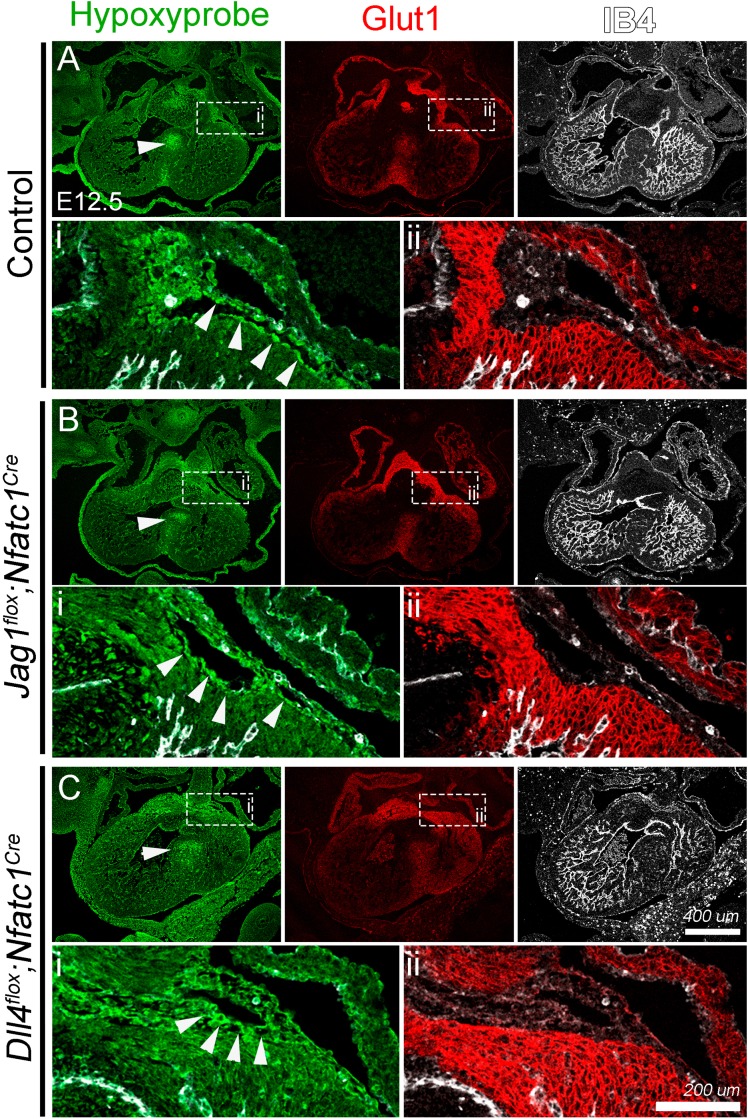
No evidence of hypoxia in Jag1flox;Nfatc1Cre and Dll4flox;Nfatc1Cre hearts at E12.5.(A) WT heart. Hypoxyprobe-1 (hypoxyprobe; green) staining is found in the ventricular septum (arrowhead), the AV groove (i), and in chamber and valve endocardium. A subset of valve mesenchymal cells in the AV cushions is also distinctly positive for hypoxyprobe. (i) Magnification of the sub-epicardial mesenchyme layer region. hypoxyprobe labels endothelial cells lining the vessels emerging from the AV groove (arrowheads). Glut1 immunostaining (red) is prominent in AV groove region, ventricular septum and weakly in compact myocardium, while is generally absent from AV cushion and sub-epicardial mesenchyme. (ii) Magnification of the sub-epicardial region at the AV groove. Glut1 immunofluorescence is strongly positive in compact myocardium underlying sub-epicardial mesenchyme (asterisk). Jag1flox;Nfatc1Cre (B) and Dll4flox;Nfatc1Cre (C) mutants show similar patterns and intensity of immunofluorescence for hypoxyprobe and Glut1 than WT.